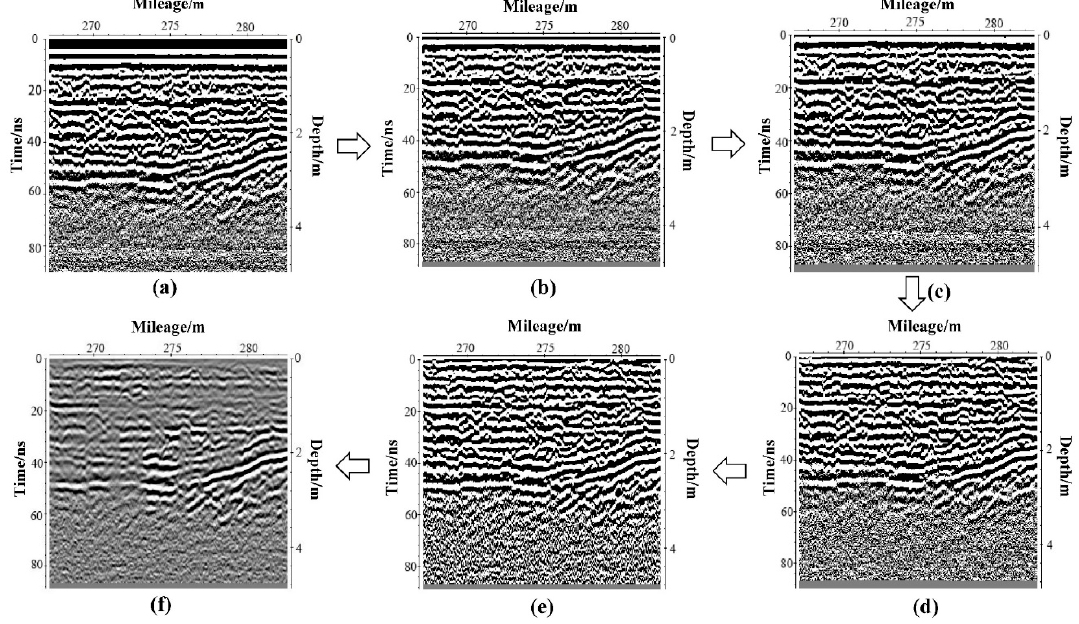
Figure 7. GPR data processing flow: ( a ) input data; ( b ) remove direct waves; ( c ) exponential gain; ( d ) average path extraction; ( e ) 1-D filtering; ( f ) 2-D filtering.